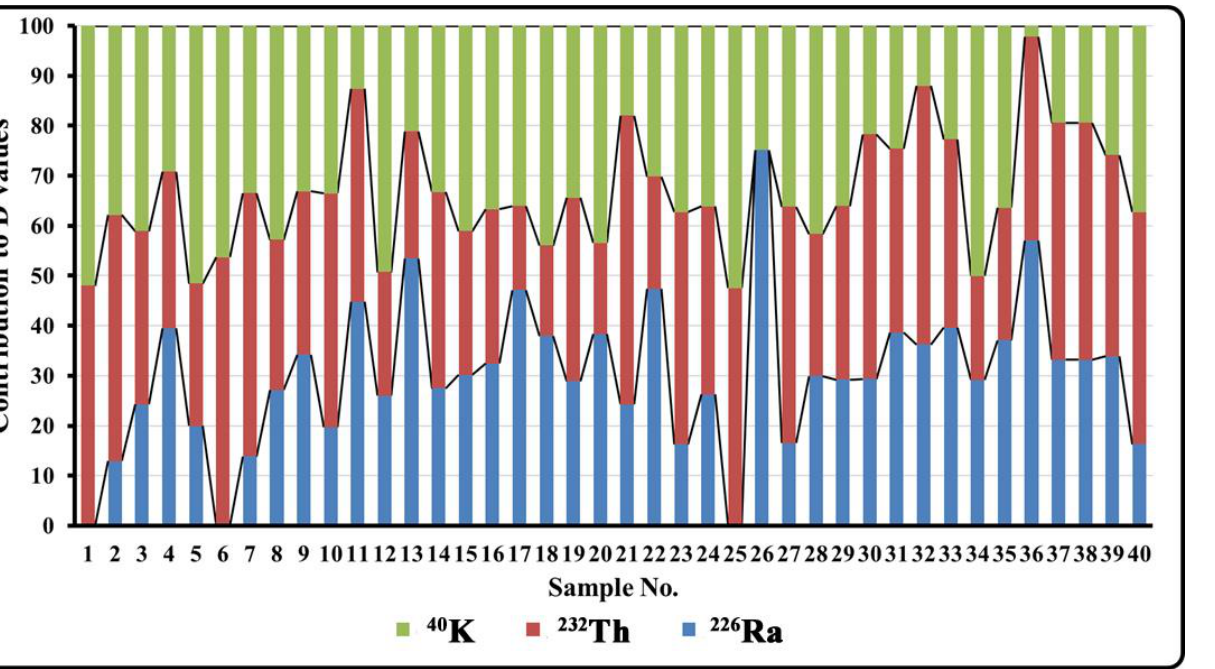
Figure 8. The contributions of 226 Ra, 232 Th, and 40 K to D values. AEDE with outdoor occupation factors of 0.2 (4.8 h d −1 ) for inhabitants ranges from 0.013 to 0.073 mSv yr −1 (mean 0.039 mSv yr −1 ). The AEDE calculated values surpass the worldwide average of 0.07 mSv yr −1 [1] in only one sampling site. ELCR calculated values range from 0.046 × 10 −3 to 0.254 × 10 −3 (mean 0.139 × 10 −3 ). These values are lower than the world’s average of 0.29 × 10 −3 [4,39].